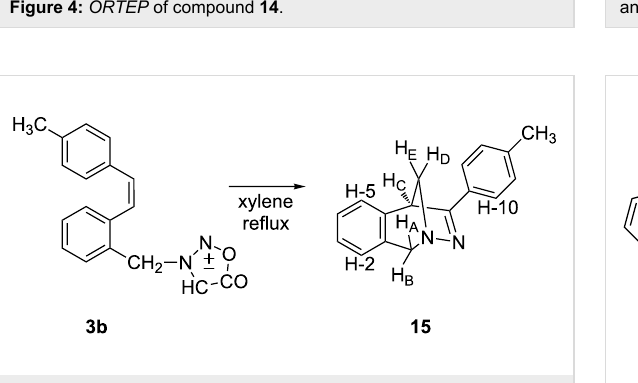
Figure 5: Proposed stereochemical pathway of sydnone ring ( CH – N ) and trans - and cis -stilbene ( α – β ).